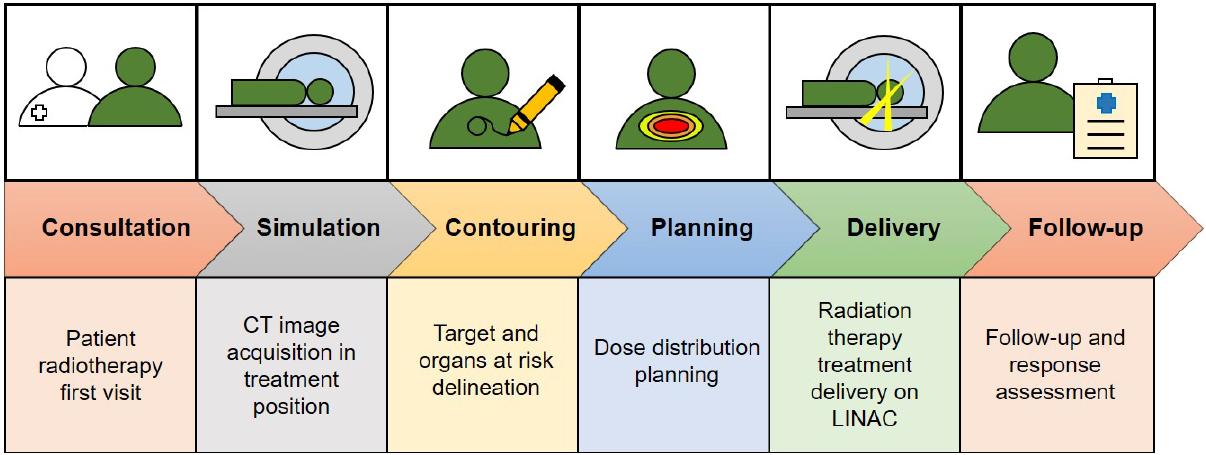
Figure 1. A schematic representation of radiotherapy workflow. Abbreviations: CT (Computed Tomography); LINAC (LINear ACcelerator).